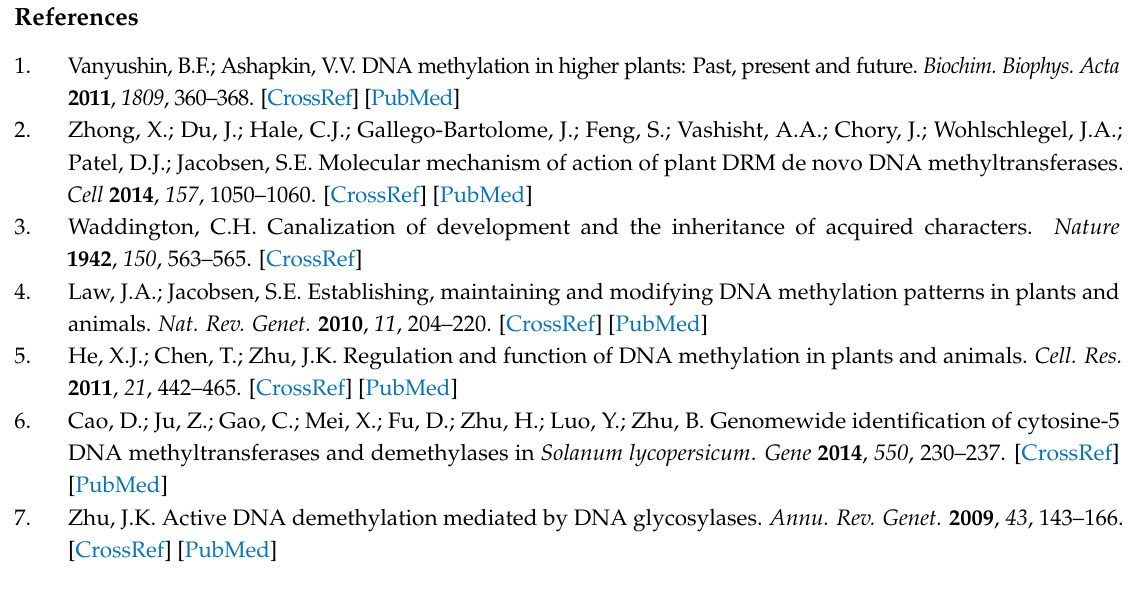
Figure S2 : Alignments of PbDME family proteins. Figure S3 : Conserved motif analysis of PbDME family proteins. Figure S4 : Expression patterns of DME genes in different organs in Arabidopsis . Figure S5 : Expression patterns of DME genes under salt stress in Arabidopsis roots. Figure S6 : Expression profiles of salt-responsive genes in Pyrus betulaefolia . Table S1 : Primers used in this paper. Table S2 : GO analysis for the PbDME genes. Table S3 : Conserved motif analysis of PbDME family proteins. Table S4 : Orthologous and paralogous gene pairs in the pear and apple DME